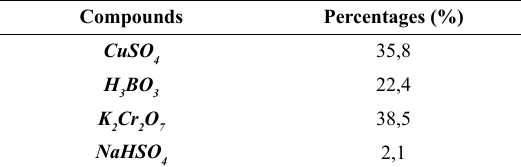
Table 1. Composition of CCB.